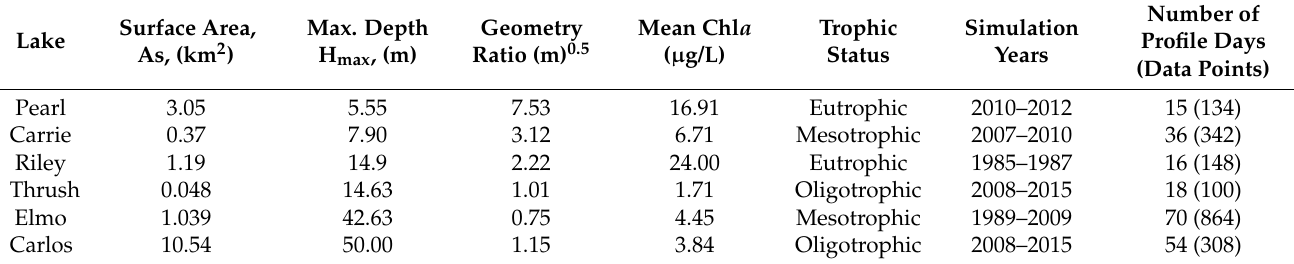
Table 2. Characteristics of six study lakes in